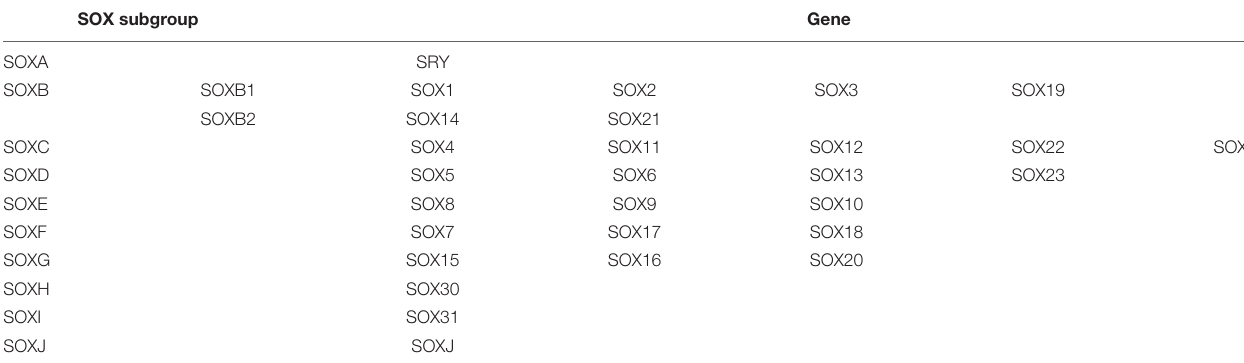
TABLE 1 | The subgroup of SOX family. SOX subgroup